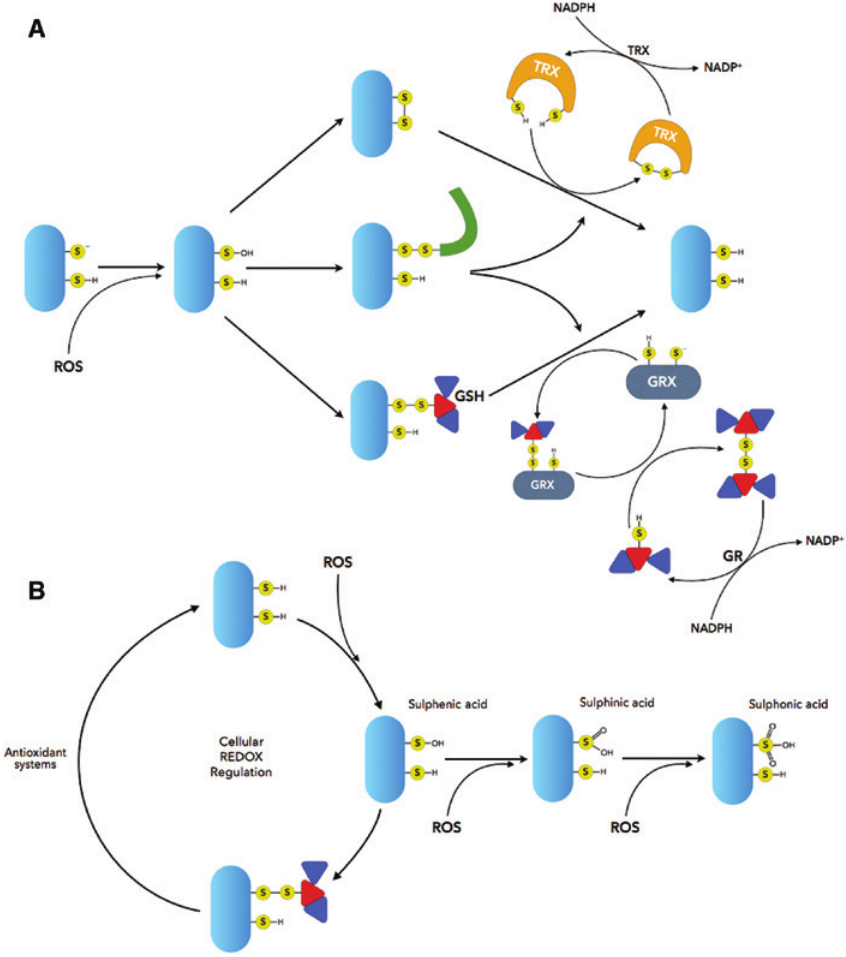
Figure 1: Redox regulation of thiol